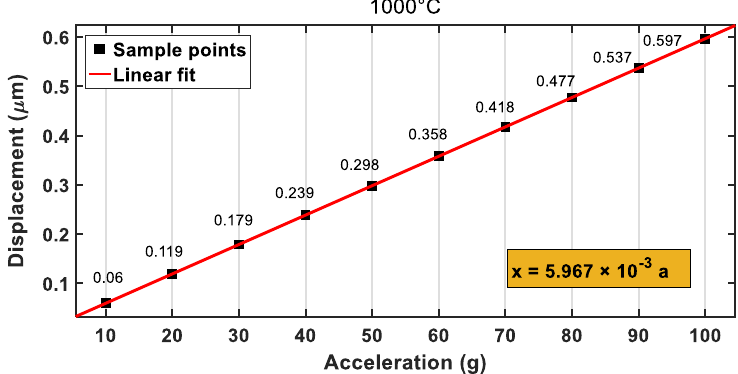
Figure 13. Relationship between displacement and acceleration at 500 °C.